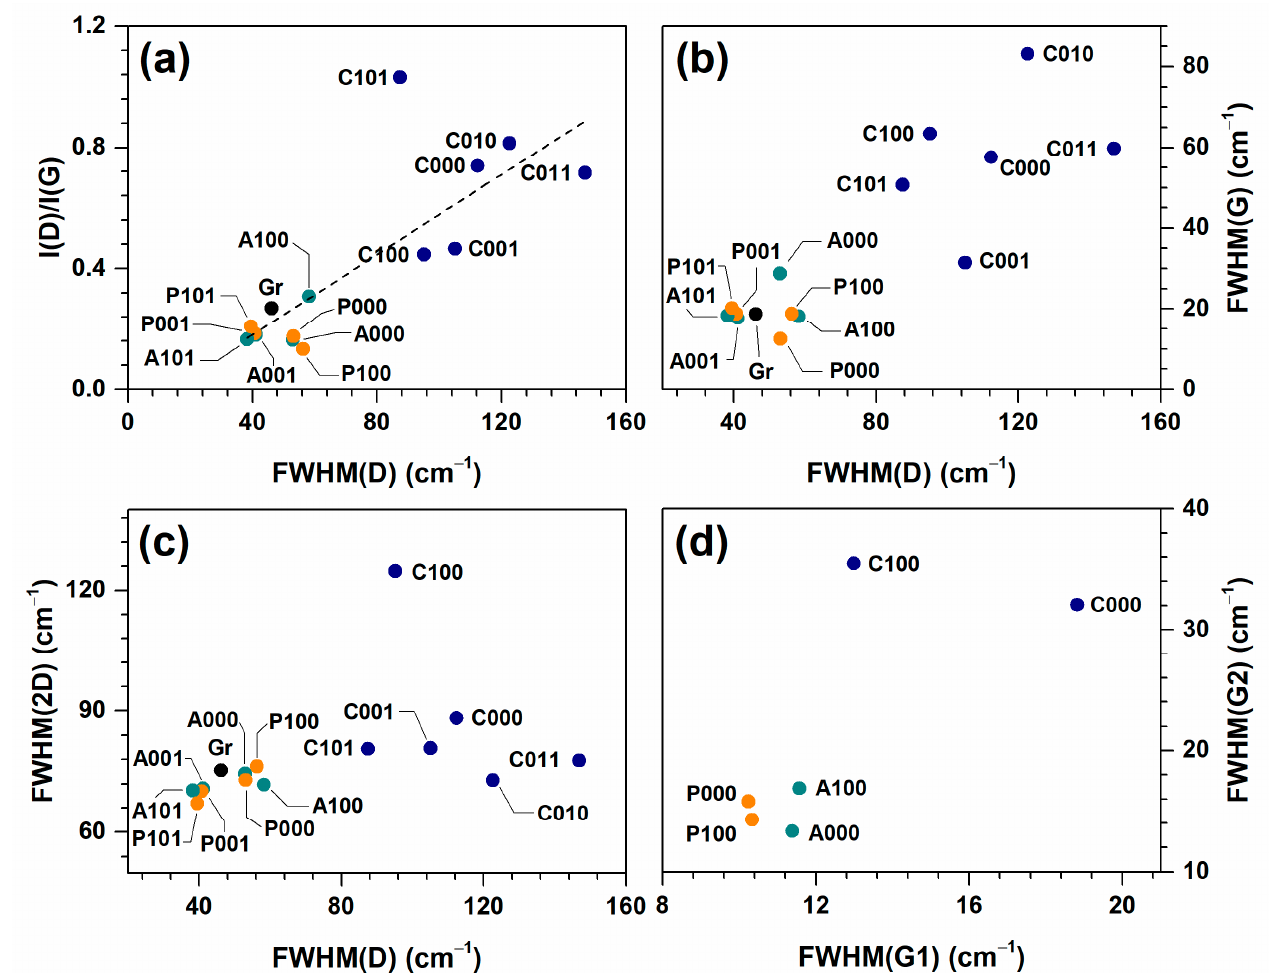
Figure 6. Correlation between FWHM data of Raman spectra of GBS products obtained using different oxidizing agents: FWHM(D) and I(D)/I(G) ratio representing defect concentration in GBS products ( a ), FWHM(D) and FWHM(G) representing defect and sp 2 bonded carbon vibrations ( b ), FWHM(D) and FWHM(2D) representing defect and second mode defect vibrations ( c ), FWHM(G1) and FWHM(G2) representing the staging index (stage I and stage II) ( d ). Three prominent bands were observed in the resonance Raman spectra of graphite.